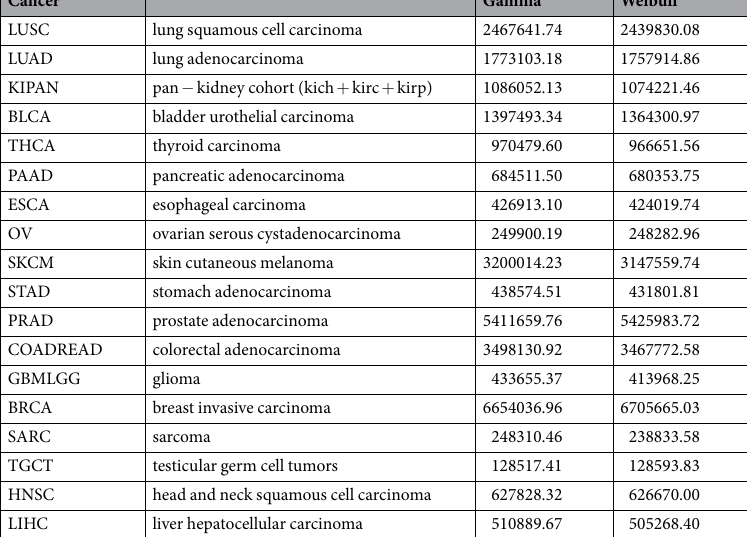
Table 2. AIC of the scaled Gamma function and the scaled Weibull function.